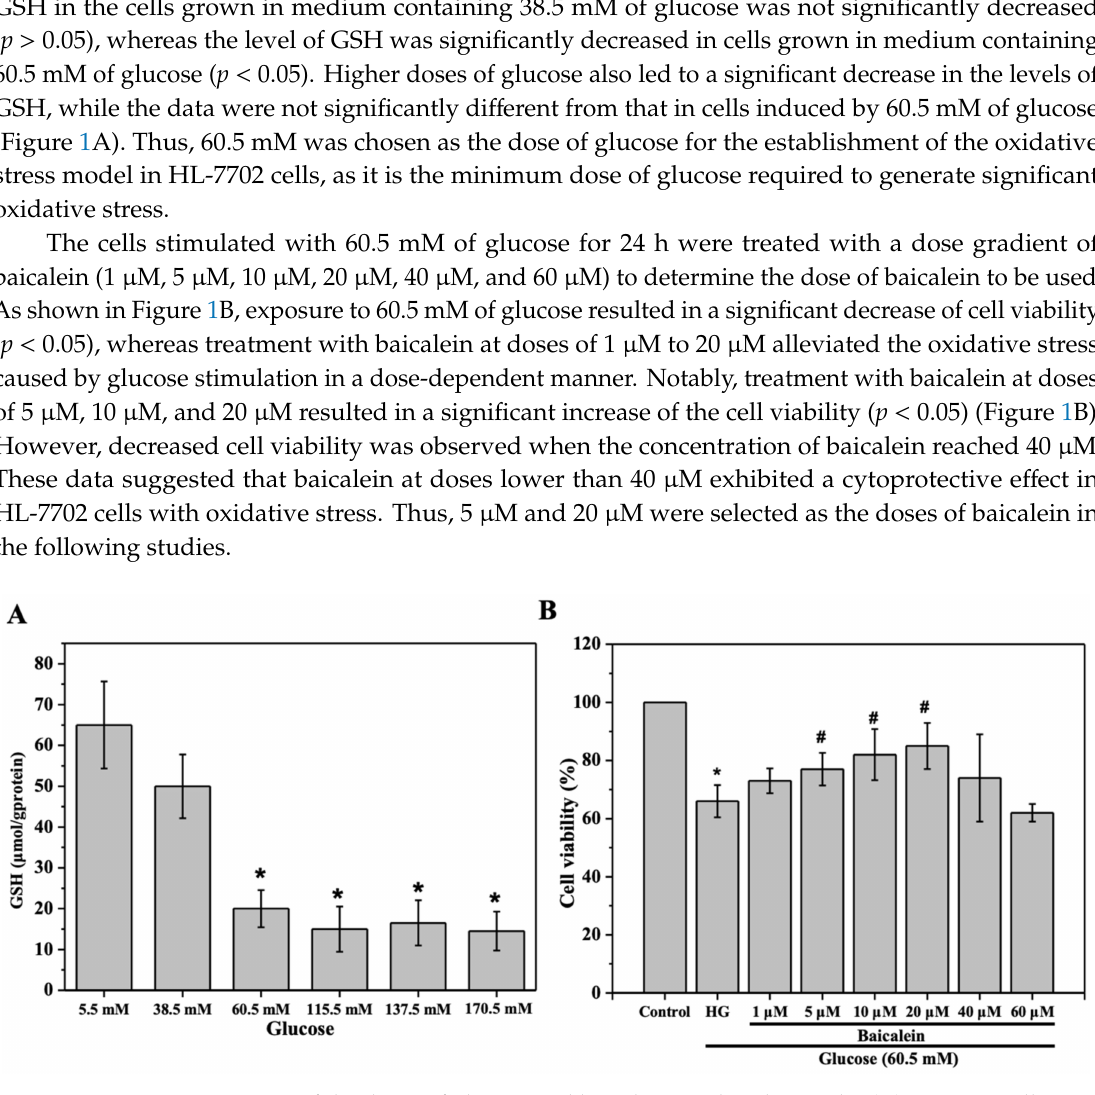
Figure 1. Determination of the doses of glucose and baicalein used in this study. ( A ) HL-7702 cells were grown in RPMI-1640 medium containing di ff erent concentrations of glucose for 24 h and the level of glutathione (GSH) in each group was determined. ( B ) HL-7702 cells were concomitantly treated with 60.5 mM of glucose and di ff erent doses of baicalein for 24 h and the viability of the cells was evaluated by 3-[4,5-dimethylthylthiazol-2-yl]-2,5-diphenyltetrazolium bromide (MTT) assay. The viability of cells exposed to 5.5 mM of glucose (control) was defined as 100%. The data were presented as the mean ± SD ( n = 3). * p < 0.05 vs. control group; # p < 0.05 vs. glucose (HG)